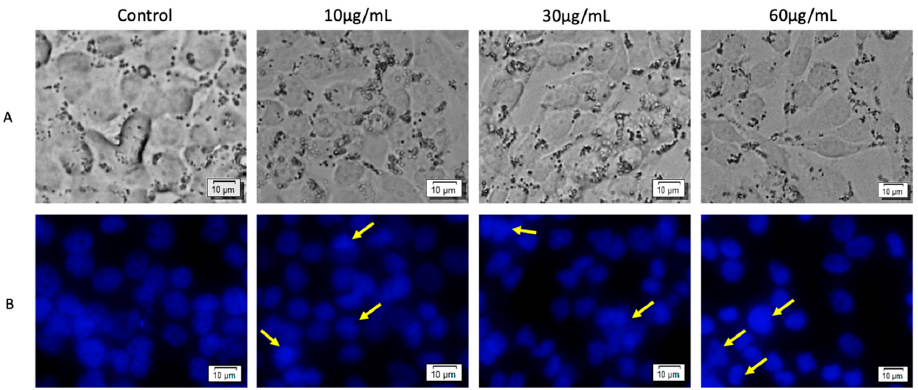
Figure 4. A375 cells treated with the OB extract at different concentrations (10, 30, and 60 µg/mL), for 72 h. ( A ) Bright field microscopy was employed to analyze cell morphology; ( B ) 4 ′ ,6-diamidino-2- phenylindole (DAPI) staining was performed for apoptotic morphological characteristics (DNA condensation and nuclear membrane blebbing are indicated by yellow arrows).